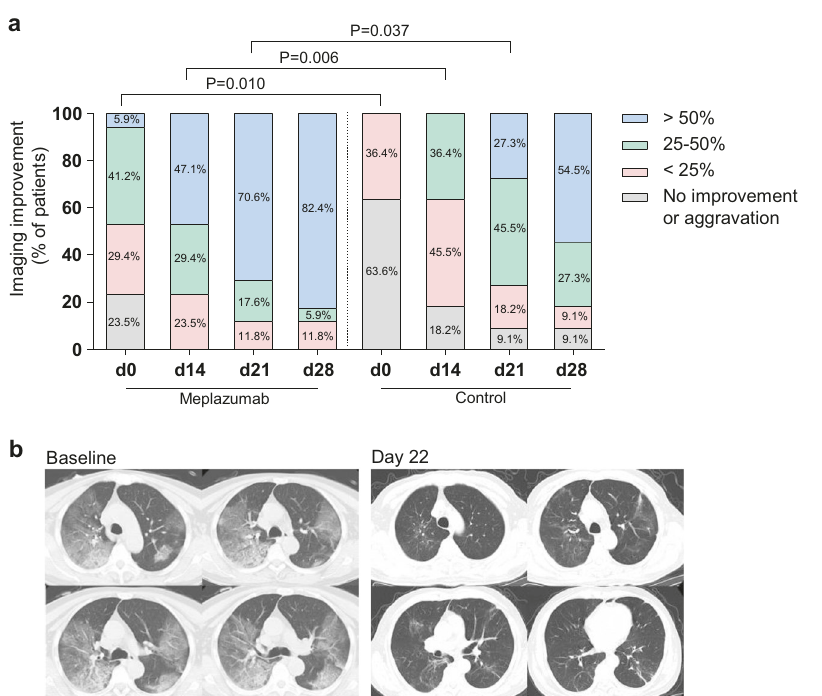
Fig. 4 a Chest imaging analysis. The P values comparing meplazumab and control at Days 7, 14, 21, and 28 were from Ordinal regression; b chest CT image, transverse chest CT images from a 65-year-old male patient showing bilateral large fl aky ground-glass shadows, and consolidation on the baseline period. On Day 22, the intrapulmonary lesions were signi fi cantly absorbed and dissipated by meplazumab add- on